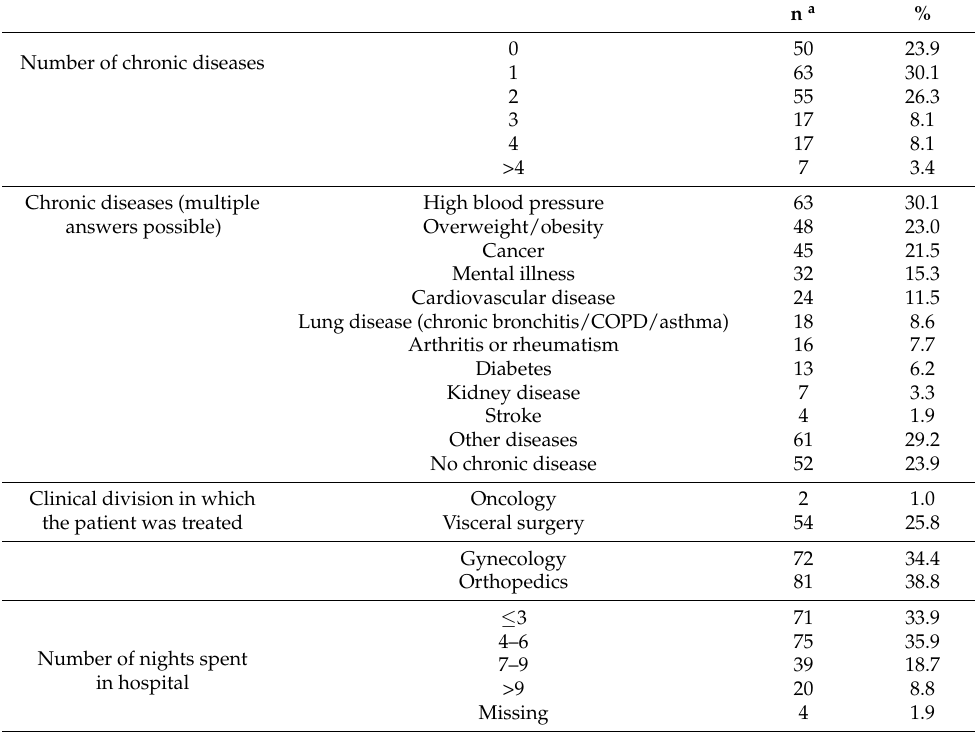
Table 3. Disease and diagnosis related characteristics of the sample (n = 209).